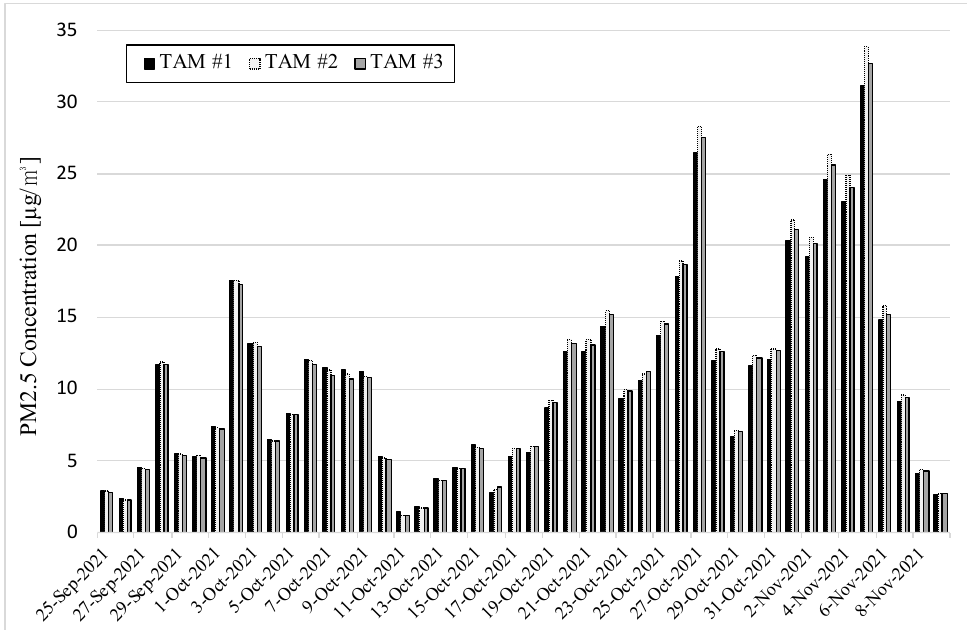
Figure 4. Comparison of three